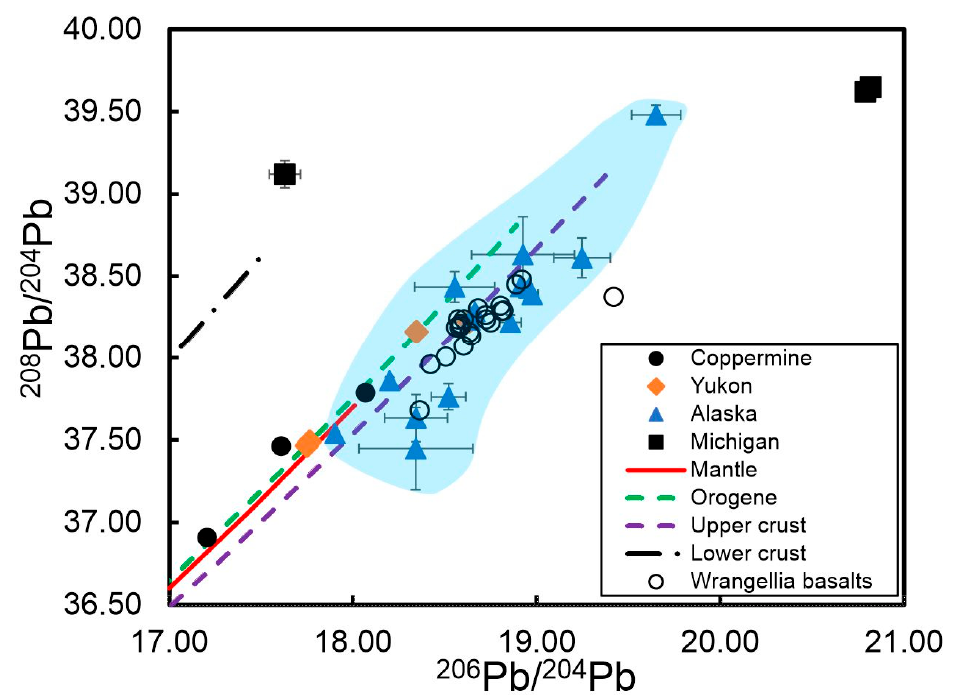
Figure 3. Diagram illustrating 208 Pb/ 204 Pb versus 206 Pb/ 204 Pb ratios for native Cu samples investigated here. Pb isotope data for mantle, orogene, and lower and upper crust evolution curves are taken from [28], whereas Pb isotope compositions for Wrangellia basalts are from [29]. Blue field denotes range of compositions for Alaskan native Cu samples. Error bars represent associated 2s level uncertainty and are not shown if these are within the size of the symbol.